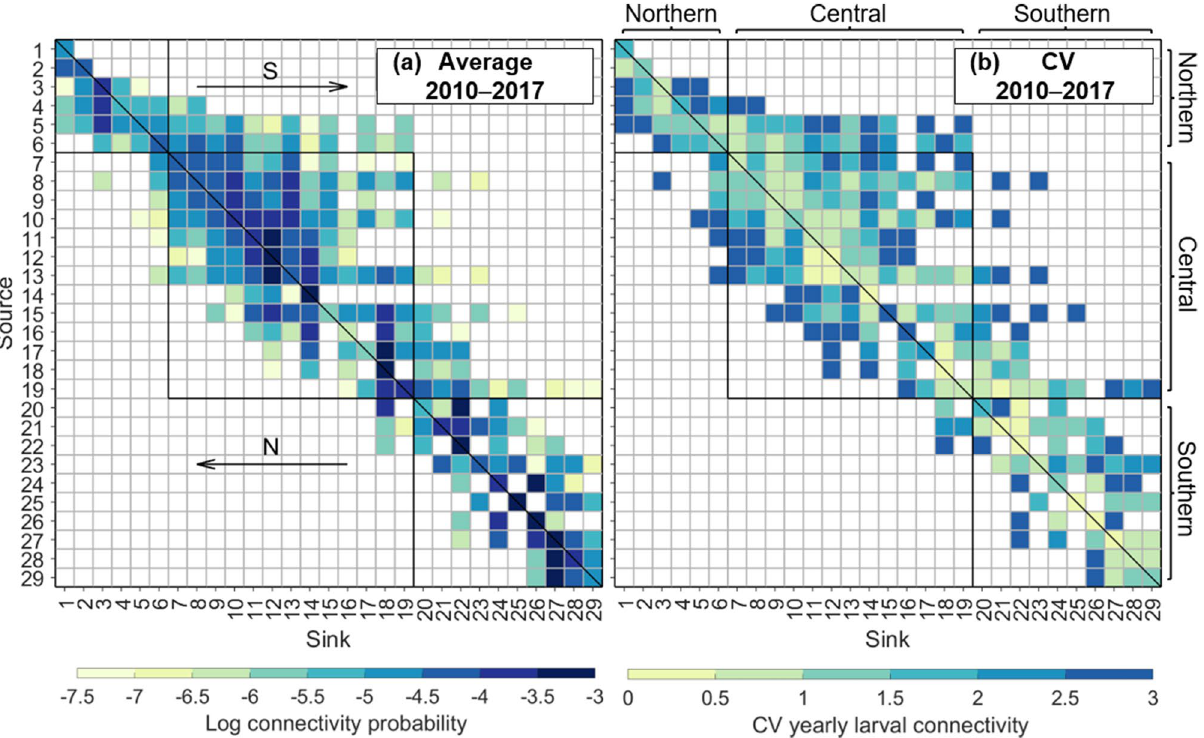
Figure 2. Connectivity patterns for modelled L. carponotatus larvae in the GBR. Particles were released annually from 2010 to 2017 (between October and December) from source regions (rows) and recruited to sink regions (columns). ( a ) Connectivity matrix representing the average annual larval connectivity among regions. Values along the diagonal represent larvae settled into the same region. ( b ) Coefficient of variation (CV) matrix of annual larval connectivity. Values along the diagonal represent CV of larval retention. In both plots, values to the right or left of the diagonal indicate poleward (“S” for southward–southeastward) or equatorward (“N” for northward–northwestward) connectivity. The northern, central and southern GBR sectors are bordered by black lined squares. Regions are ordered from north to south following the same order as presented in the legend of the upper inset in Fig. 1. The figure was created using MATLAB v9.4, available at https:// www. mathw orks. com/ produ cts/ matlab. southern GBR was predominantly poleward (61% of connections) and resulted in longer-distance dispersal events towards southern reefs than equatorward dispersal events (e.g. rows 7–10, 19, 23; Fig. 2a). Larvae sourced from the far northern GBR (< 14°S) dispersed mostly equatorward (e.g. rows 2–3; Fig. 2a). Larval retention was common in all GBR regions (values along the diagonal), although it was variable between regions (Fig. 2a) and over time (Fig. 2b). The degree of larval connectivity among reefs throughout the GBR was highly variable, both spatially and temporally (Fig. 2b). The CV in connectivity values ranged from 0.32 to 2.83, with a median distribution of 1.84 (Fig. 2b), indicating very large temporal fluctuations in connectivity between years. Higher CV values were identi- fied in equatorward dispersal events and over longer-distances poleward (Fig. 2b). The strength of connectivity significantly decreased with higher CV (r 2 = 0.57, P < 0.00001, exponential decay; Fig. 2; see Supplementary Fig. S3), suggesting that the strongest connectivity patterns were more consistent in time, but weaker and longer dispersal events were more variable.